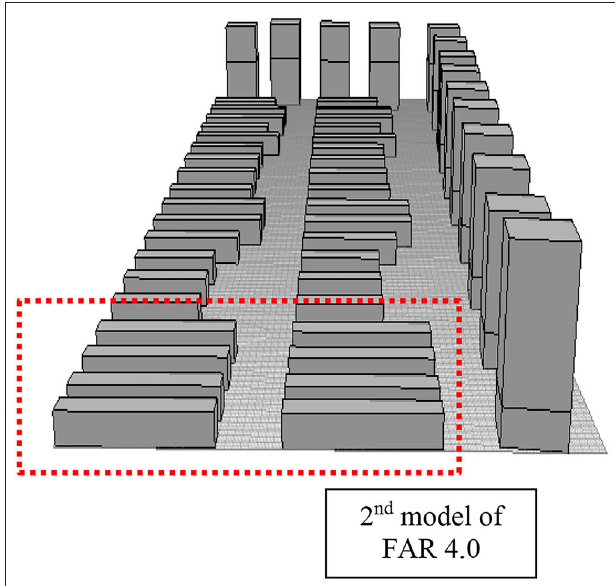
FIGURE 9 | Second FAR 4.0 model. Reduced height of towers by five floors. Added eight more row housing blocks of up to six-storey at the south section (in red-dotted